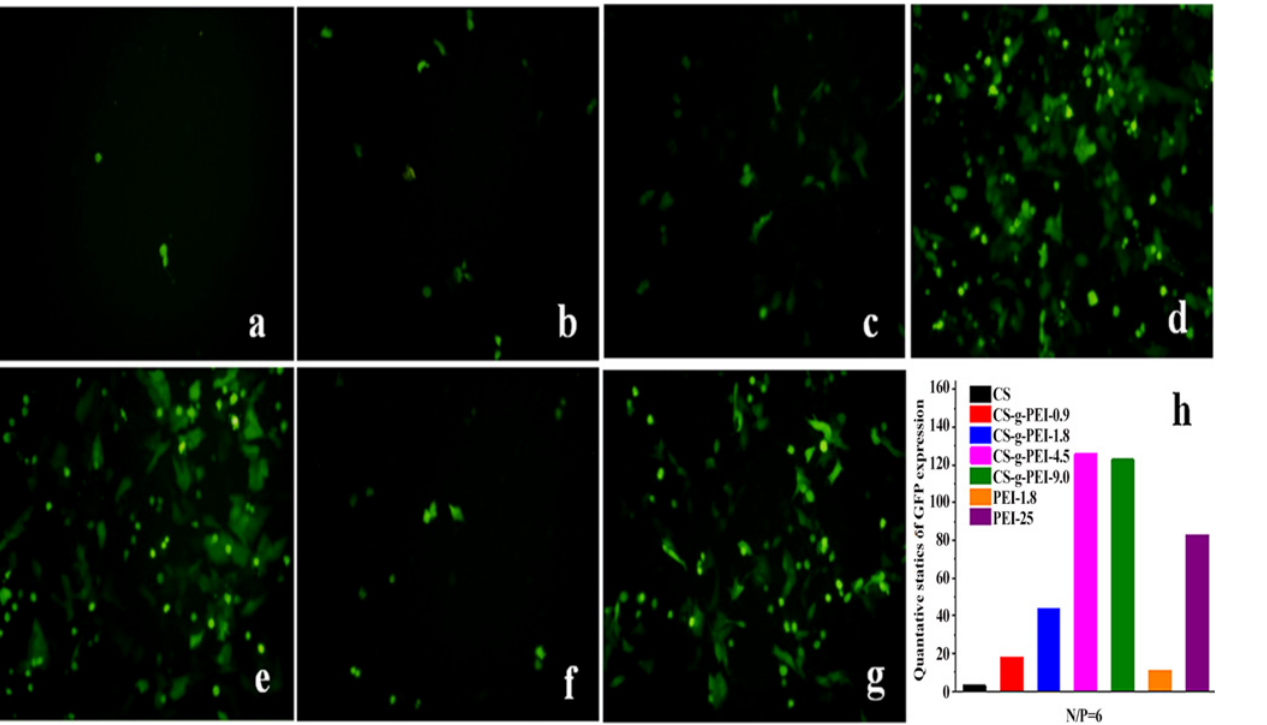
Fig 8. Fluorescence images of HEp-2 cells exposed to the polyplexes (N/P = 6) after transfection of 24 h. (a) CS/pDNA, (b) CS- g -PEI-0.9/pDNA, (c) CS- g -PEI-1.8/pDNA, (d) CS- g -PEI-4.5/pDNA, (e) CS- g -PEI-9.0/pDNA, (f) PEI-1.8/pDNA and (g) PEI-25, using pGFP-N2 as report gene. Relative quantitative GFP expression efficiency of polyplexes was shown